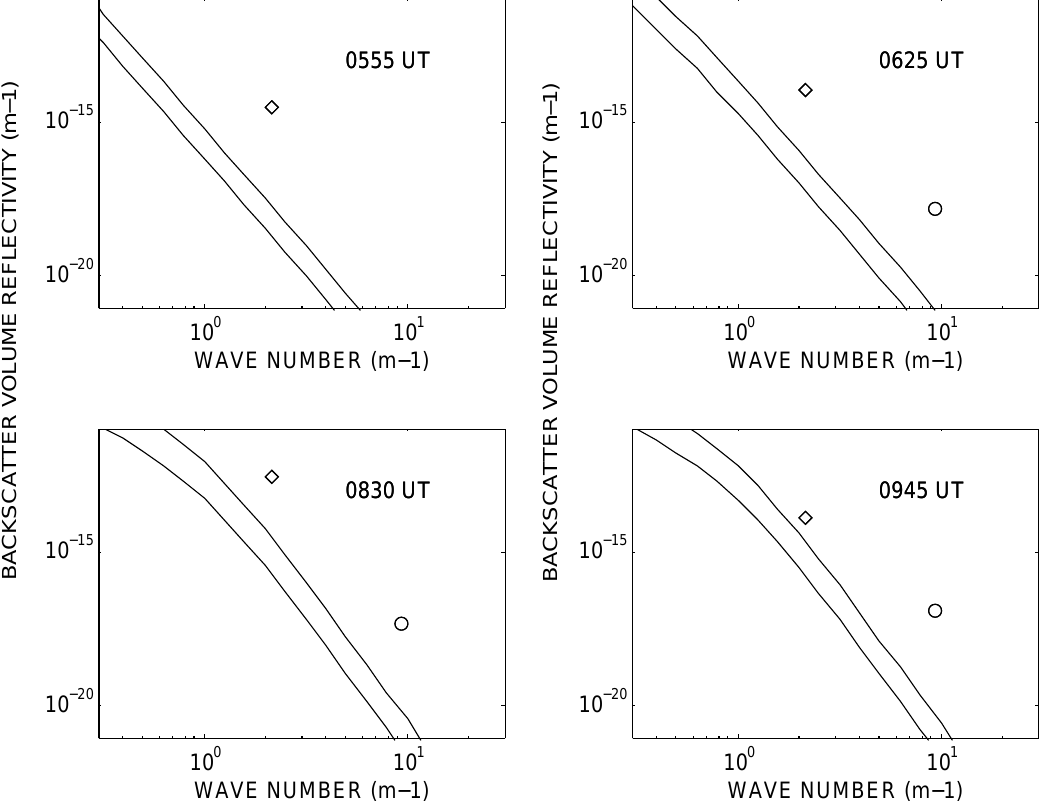
Fig. 4. Radar volume reflectivities estimated from radar observations (ESRAD as diamonds, EISCAT as circles) and from turbulent the- ory (lines) for four different times indicated on the plots. The lower line on each plot correspond to N 2 =6 × 10 − 4 s − 2 , the upper line to N 2 =7.6 × 10 − 5 s − 2 . All curves for energy dissipation rate of 12.5mW/kg. Neutral densities and temperatures are from the MSIS90E model (Hedin, 1991), electron and ion densities and electron density gradient from the model in Fig. 3, Schmidt number is calculated from the ion densities (including negative ions). Prandtl number is assumed to be 0.83 (see text and Stebel et al., 2004 for further